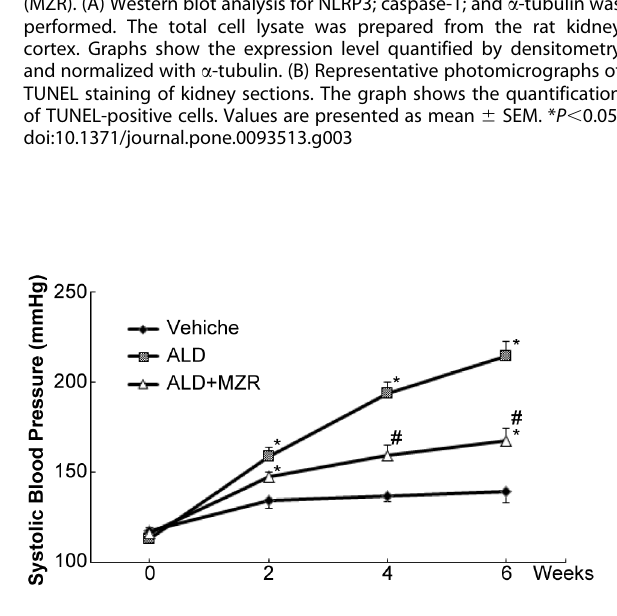
Figure 4. Mizoribine ameliorates aldosterone-induced hyper- tension. Following infusion of aldosterone (ALD), hypertension developed over time. In contrast, mizoribine (MZR) attenuated the degree of hypertension caused by ALD. Values are presented as mean 6 SEM. * P , 0.05 vs. vehicle group; # P , 0.05 vs. ALD group.